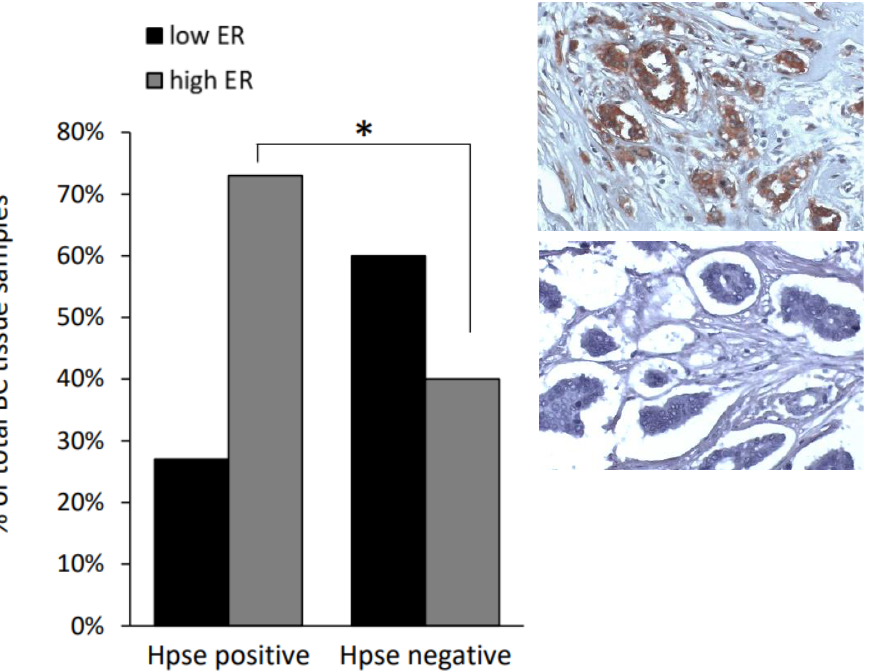
Figure 7. Sections of human ER + BC tissue samples ( n = 58) were processed for immunohisto- chemistry with anti-ER α and anti-heparanase (Hpse) antibodies, as described in Methods. Inset: representative images of heparanase-positive (top) and heparanase-negative (bottom) breast tumor tissue specimens (invasive ductal carcinoma), original magnification × 200. To define tumor as Hpse-positive, a cutoff point of 25% immuno-stained tumor cells was used, as in Ref. [53]. The intensity of ER α staining was scored as weak (1), moderate (2), or strong (3), as described in Methods; tumors with staining score 1 were categorized as “low ER” (black bars); tumors with staining score 2 and 3 as “high ER” (grey bars). Chi-squared analysis was then used to assess the relationship between heparanase positivity and high versus low ER levels. Significant correlation between expression of heparanase and high ER levels was noted:an almost 2-fold higher proportion of high ER expression was detected in heparanase-positive versus heparanase-negative tumors (73% vs. 40%, chi-square test * p = 0.0135).